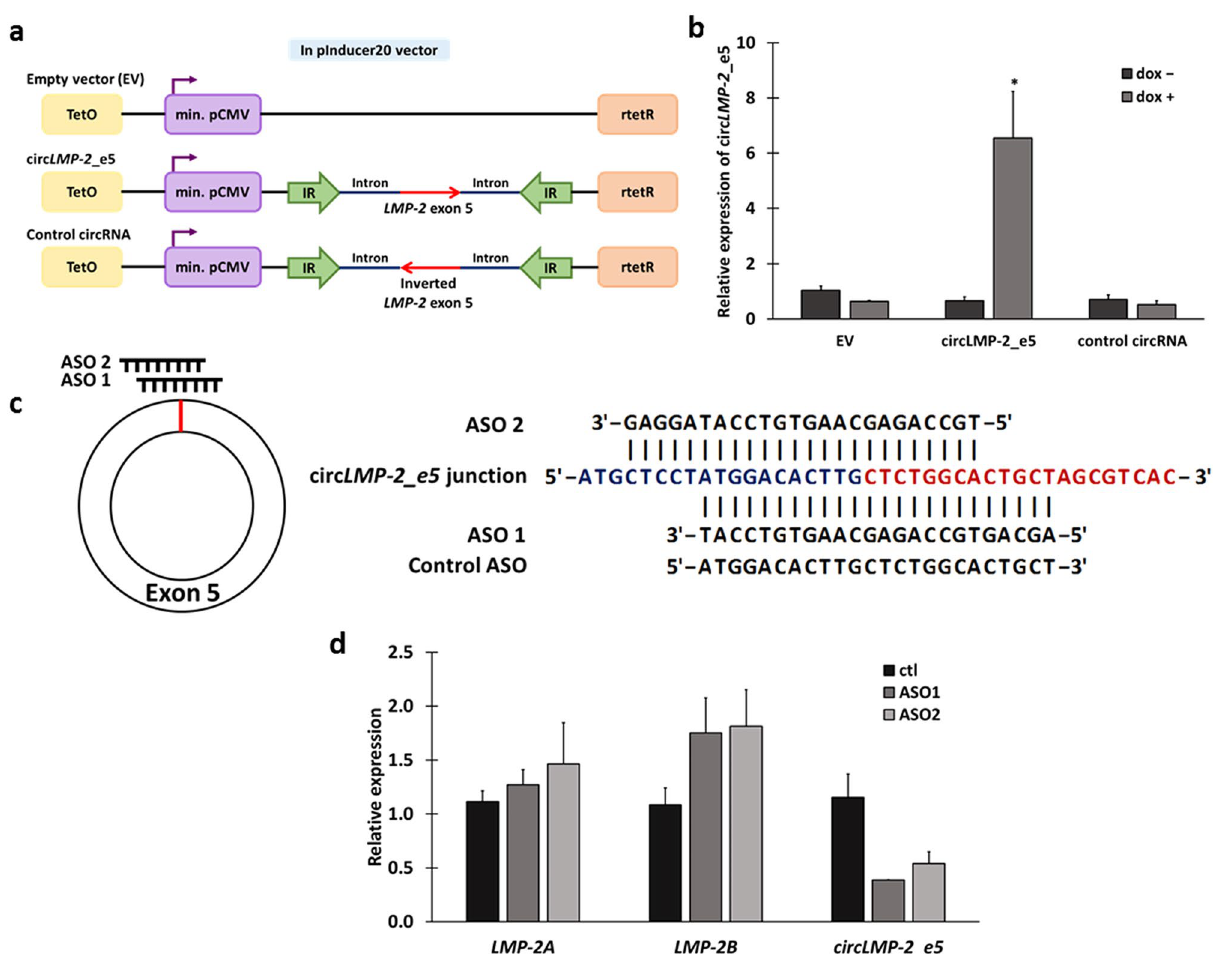
Figure 5. Over-expression and knockdown of circ LMP-2 _e5 in P3HR1 and GM12878 cell lines respectively. ( a ) Schematic diagram of pInducer constructs, a Tet-on inducible lentiviral system used to induce circ LMP-2_e5 and control circRNA (inverted LMP-2 exon 5) over-expression. ( b ) Relative circ LMP-2 _e5 expression with or without doxycycline induction in P3HR1 cells stably expressing EV, circ LMP-2 _e5, and control circRNAs. Data was normalized to ACTB and represents the mean ± SEM of six independent experiments. ( c ) Schematic diagram of ASO targeting circ LMP-2_e5 BSJ. Control ASO is in the sense orientation but with the same coordinate as ASO 1. (D) Relative linear LMP-2 and circ LMP-2_e5 expression in GM12878 cells transfected with ASO 1, ASO 2 and control ASO for 72 h. Data was normalized to ACTB and represents the mean ± SD of two independent experiments. [≤ 0.05 (*) and ≤ 0.01 (**)] as determined by Student’s t -test are